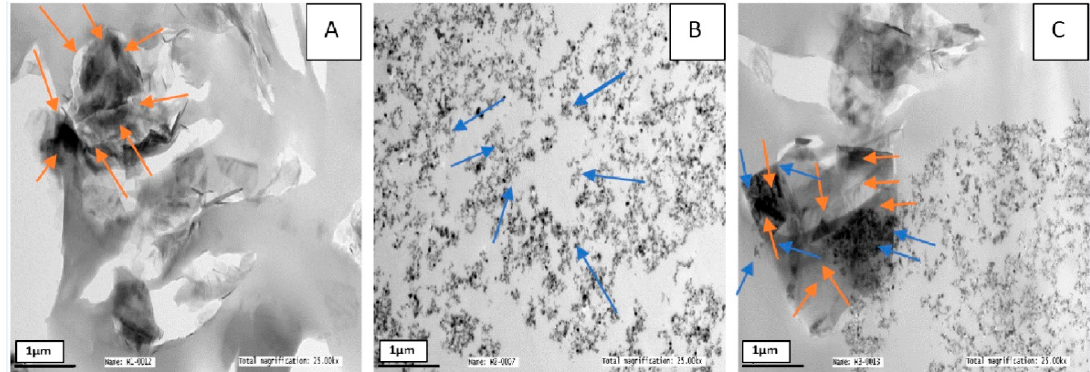
Figure 1. TEM images of ( A ) graphene, ( B ) titanium dioxide, and ( C ) graphene and titanium dioxide mixed together in powder form at 1 µm scale and 25.00 kx magnifications.